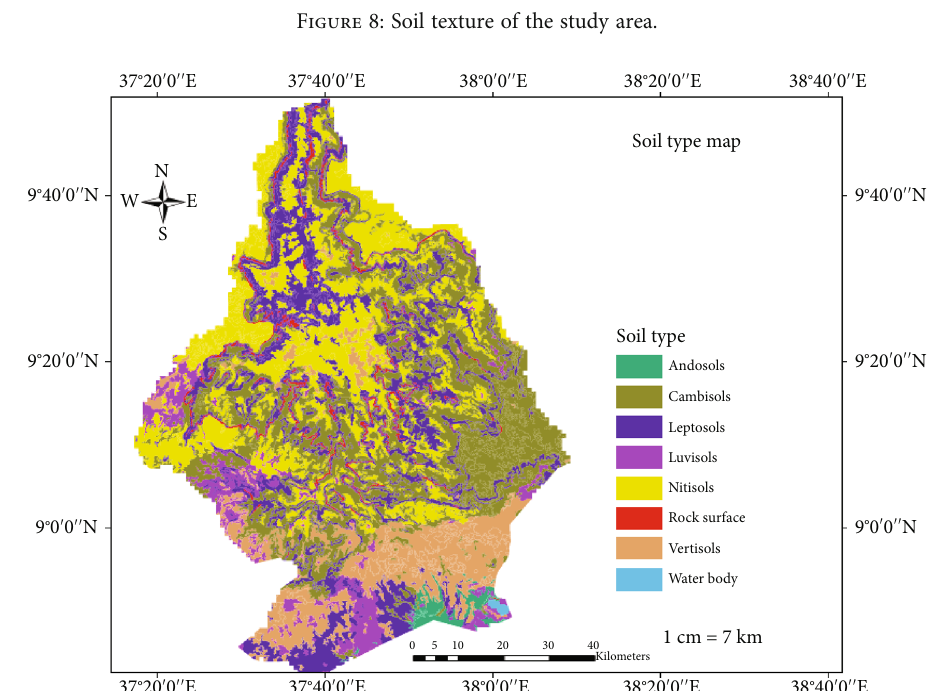
Figure 9: Soil types of the study